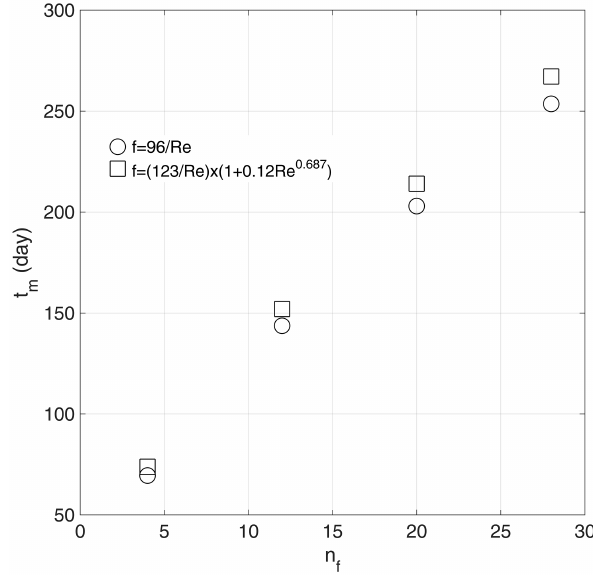
Figure 14. Mean travel time t m at varying numbers of fractures n f for linear and nonlinear